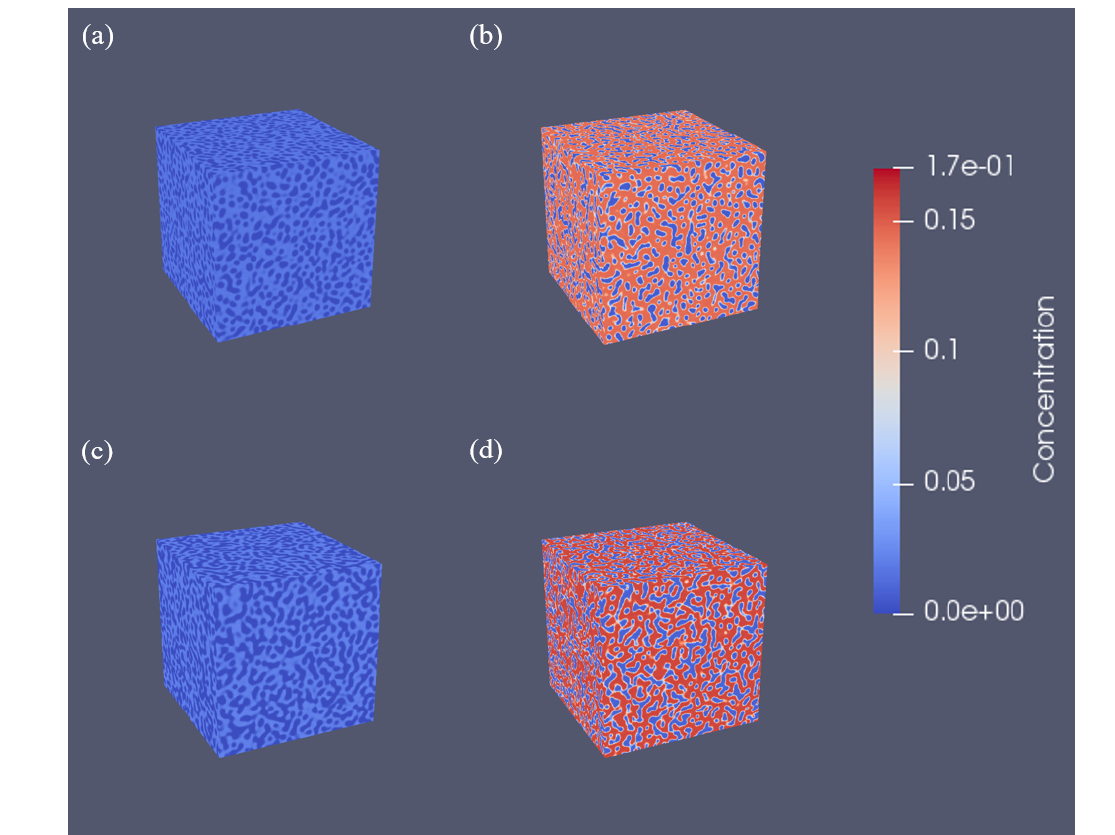
Figure 18. Al concentration at t ∗ = 2.5 × 10 6 . The system size is 256 ∆ x × 256 ∆ y × 256 ∆ z ( a ) 35Cr-1Al, ( b ) 35Cr-10Al, and ( c ) 40Cr-1Al, ( d )